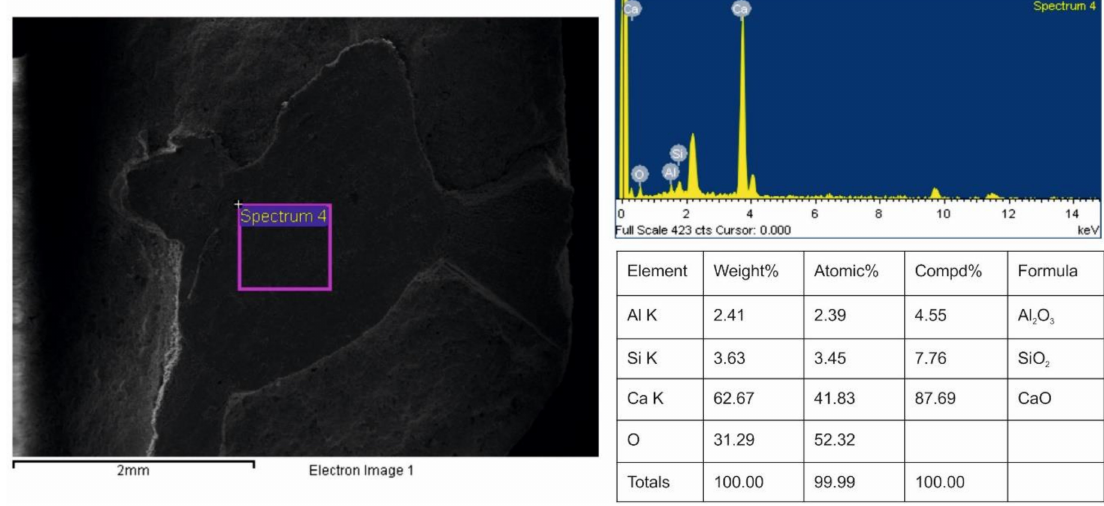
Figure 4. LayersofcalciteontheMPC2surface, observedbystereomicroscopeafter720hofCO 2 treatment. Figure 4. Layers of calcite on the MPC2 surface, observed by stereomicroscope after 720 h of CO 2 treatment.